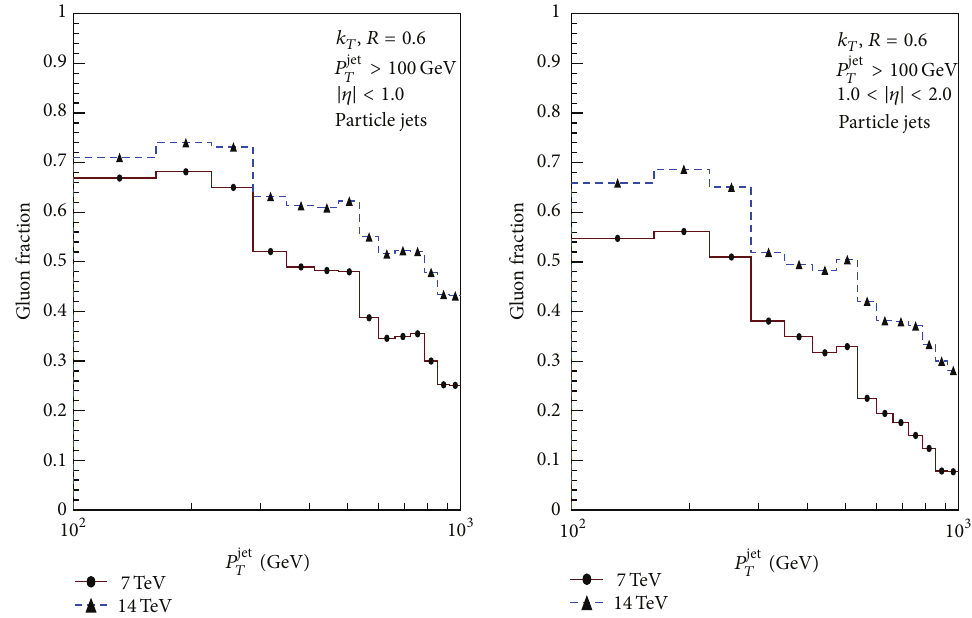
Figure 2: Fraction of gluon initiated jets differentiated via matching of the two particle leading jets to the hard partons of the leading-order process as a function of jet 𝑃 𝑇 from 𝑘 𝑇 algorithm at √𝑠 = 7 TeV compared to √𝑠 = 14 TeV in the pseudorapidity bins of |𝜂| < 1 and 1 ≤ |𝜂| < 2 .